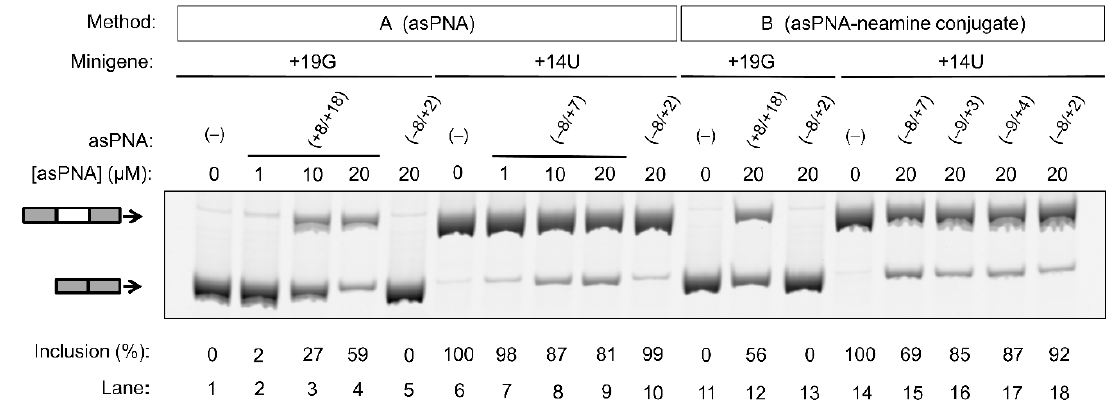
Figure 4. Effect of asPNAs on tau pre-mRNA exon 10 splicing. Representative RT-PCR data of the cell culture splicing assays are shown. The levels of exon 10 inclusion were derived from three experimental replicates (samples from independent minigene transfections, with the standard deviations <10%). In method A, the PNAs were mixed with the minigene transfection mixture and incubated for 20 min prior to transfection. In method B, the PNA–neamine conjugates were added to the cell culture medium 5 h after minigene transfection. Application of asPNA–neamine conjugates could restore the exon 10 inclusion level to close to 50%.